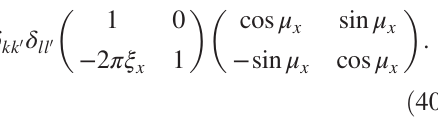
FIG. 15. Eigenvalues of the σ and π modes as a function of the bunch population for the FCC-ee-Z parameter, where ν ¼ 0 . 018 . The tune and growth rate are plotted in (a) and and ν z (b), respectively. The red and blue points represent the σ and π modes, respectively.